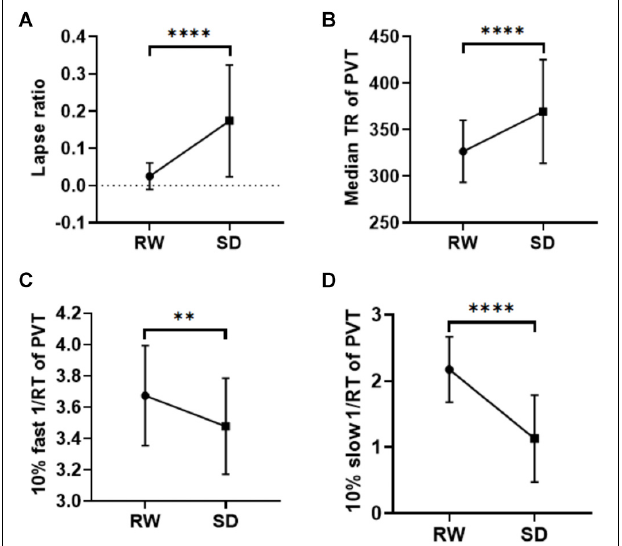
FIGURE 1 | Behavioral results. After SD, participants showed more lapse ( p < 0.0001, A ), a slower median RT in the PVT ( p < 0.0001, B ), a decreased 10% fast 1/RT ( p < 0.002, C ), and reduced 10% slow 1/RT ( p < 0.0001, D ). ** p < 0.01, **** p < 0.0001. RW, rested wakefulness; SD, sleep deprivation; KSS, Karolinska Sleepiness Scale; PVT, psychomotor vigilance test; RT, reaction